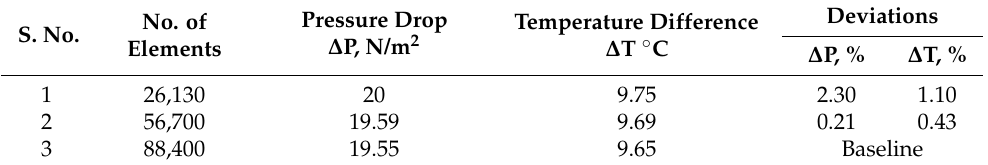
Table 1. Grid independence